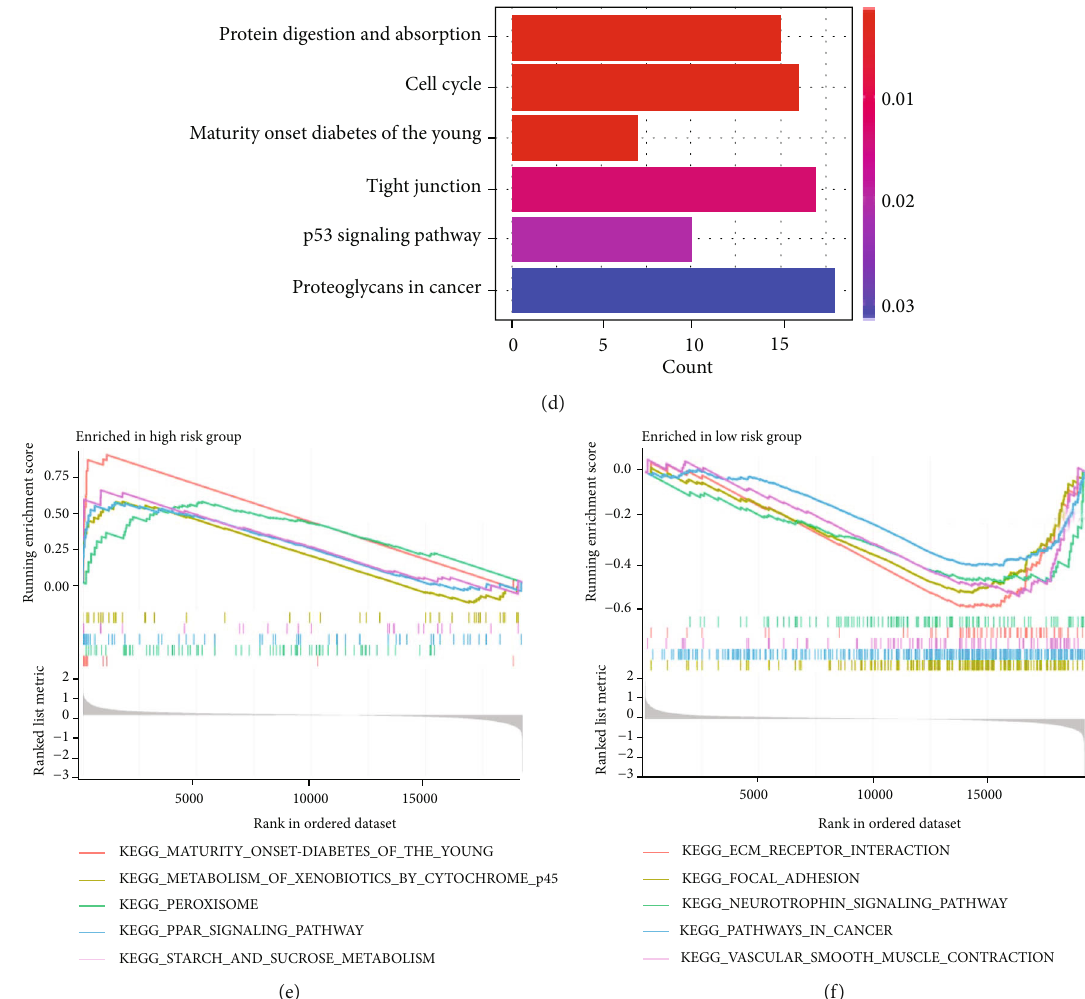
Figure 3: Potential mechanism of MAIP1 in EC. (a) Volcano map of di ff erentially expressed genes between MAIP1 high and MAIP1 low groups. (b) Correlation heat map of 40 genes with the most obvious positive and negative correlations. (c) Results of GO functional enrichment of DEGs. (d) Results of KEGG functional enrichment of DEGs. (e) GSEA enrichment results for MAIP1 high group. (f) GSEA enrichment results for MAIP1 low